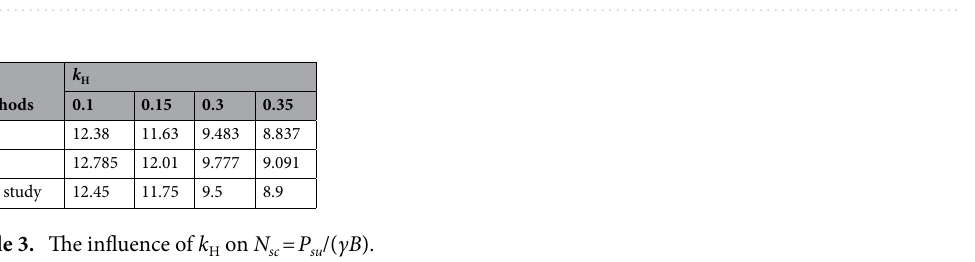
Figure 7. The proposed failure mechanism undern the seismic condition: ( a ) calculation with B = 2 m, N 1 = 20, Δ x = 0.1, k H = 0.2; ( b ) numerical convergence.